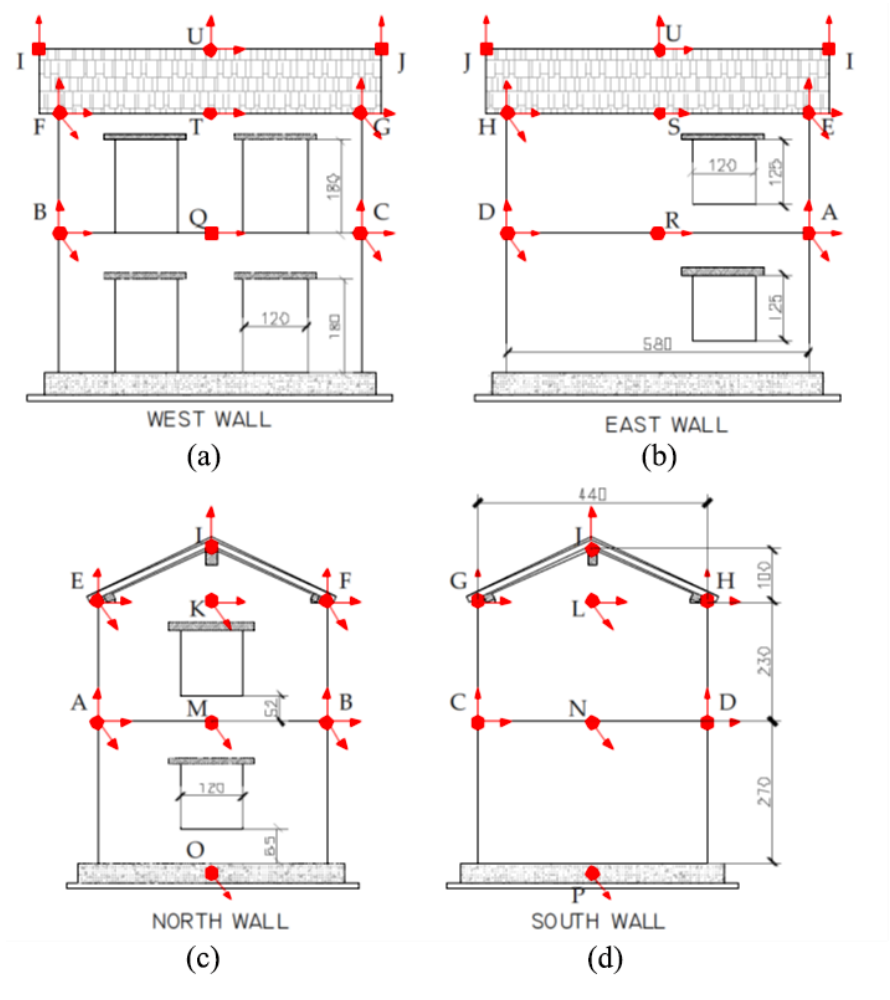
Figure 5. Drawings of Pavia Building 1 with the positions of accelerometers: ( a ) West wall. ( b ) East wall. ( c ) North wall. ( d ) South wall